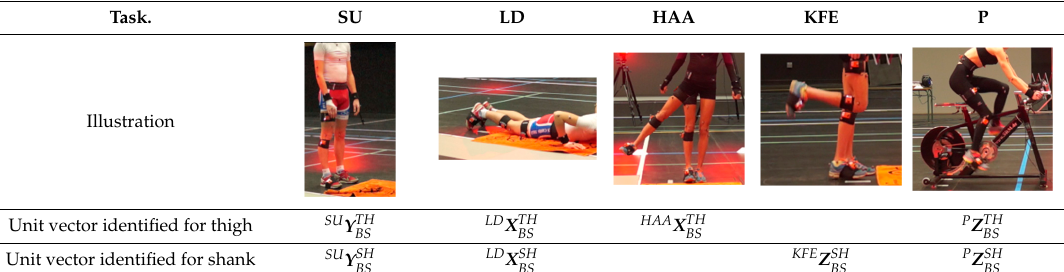
Table 1. Each task allowed the identification of one or two body segment axis orientations in relation to the IMU frames. Table 1. Illustration of the calibration tasks used for the di ff erent calibration methods. Each calibration task allows the identification of at least one unit vector for the thigh or shank body segment frames. SU: Table 1. Illustration of the calibration tasks used for the different calibration methods. Each calibration Table 1. Illustration of the calibration tasks used for the different calibration methods. Each calibration Table 1. Illustration of the calibration tasks used for the different calibration methods. Each calibration Table 1. Illustration of the calibration tasks used for the different calibration methods. Each calibration Table 1. Illustration of the calibration tasks used for the different calibration methods. Each calibration Standing up posture; LD: Lying down; HAA: Hip abduction / adduction; KFE: Knee flexion / extension; task allows the identification of at least one unit vector for the thigh or shank body segment frames. task allows the identification of at least one unit vector for the thigh or shank body segment task allows the identification of at least one unit vector for the thigh or shank body segment frames. task allows the identification of at least one unit vector for the thigh or shank body segment frames. task allows the identification of at least one unit vector for the thigh or shank body segment frames. P: Pedaling.